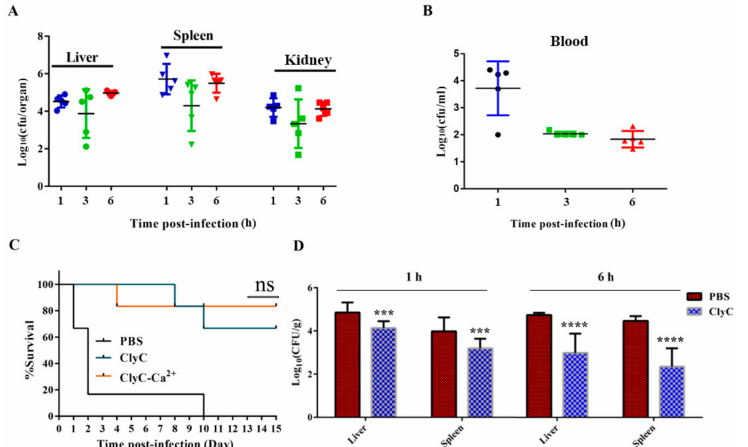
Figure 5. ClyC protects mice from lethal S. aureus infection. Bacterial burden in organs ( A ) and